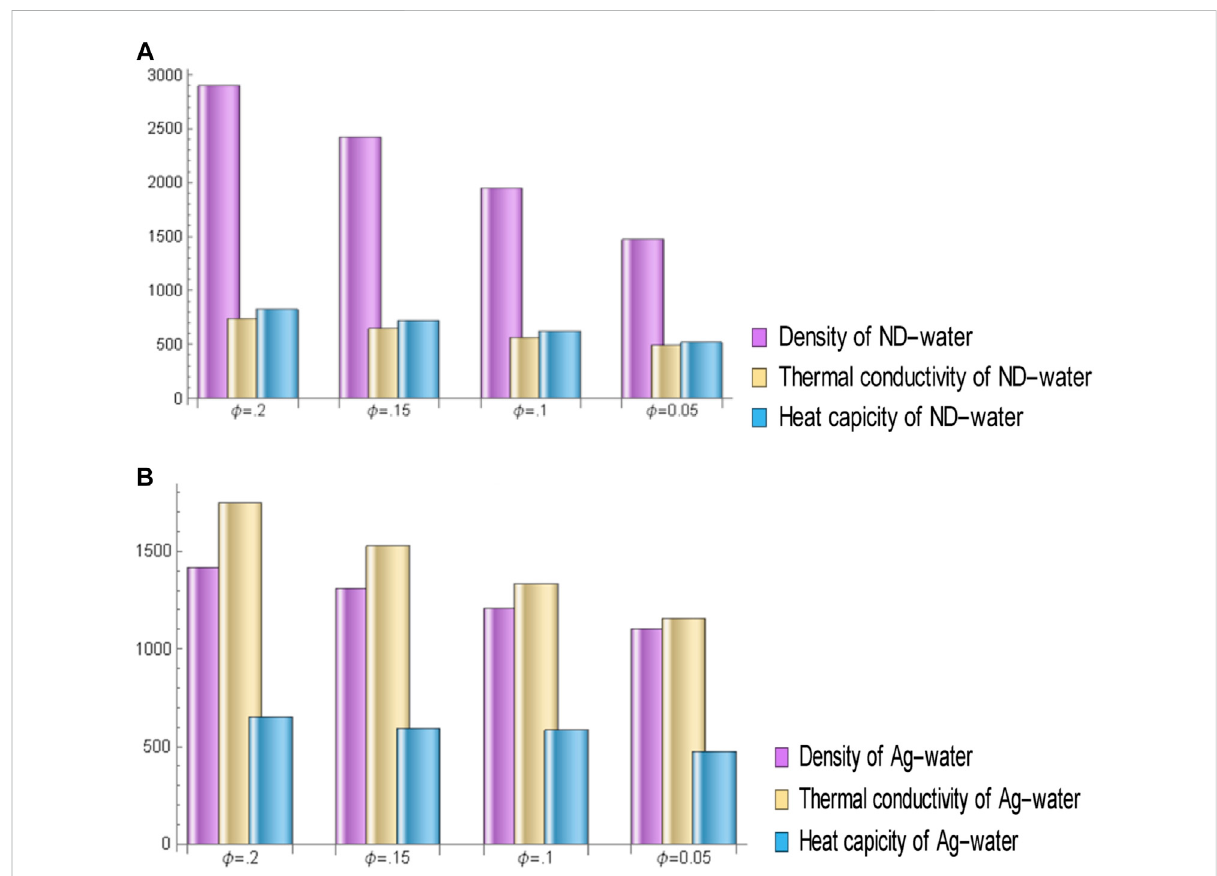
FIGURE 6 (A) In fl uence of volume fraction on the thermos-physical values for nanodiamond/water. (B) In fl uence of volume fraction on the thermos- physical values for